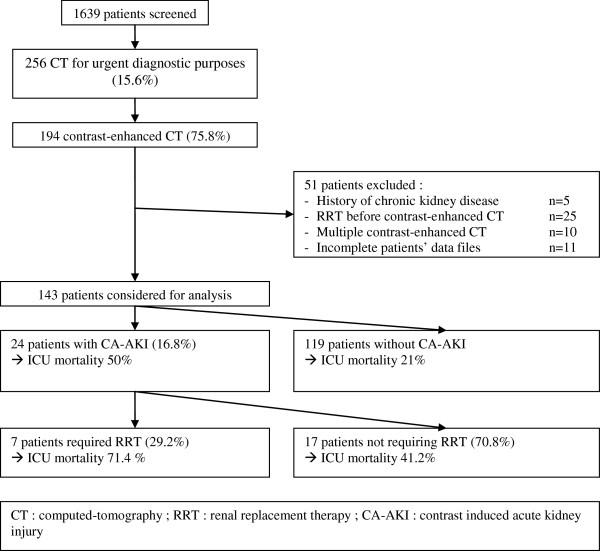
Study flow chart.